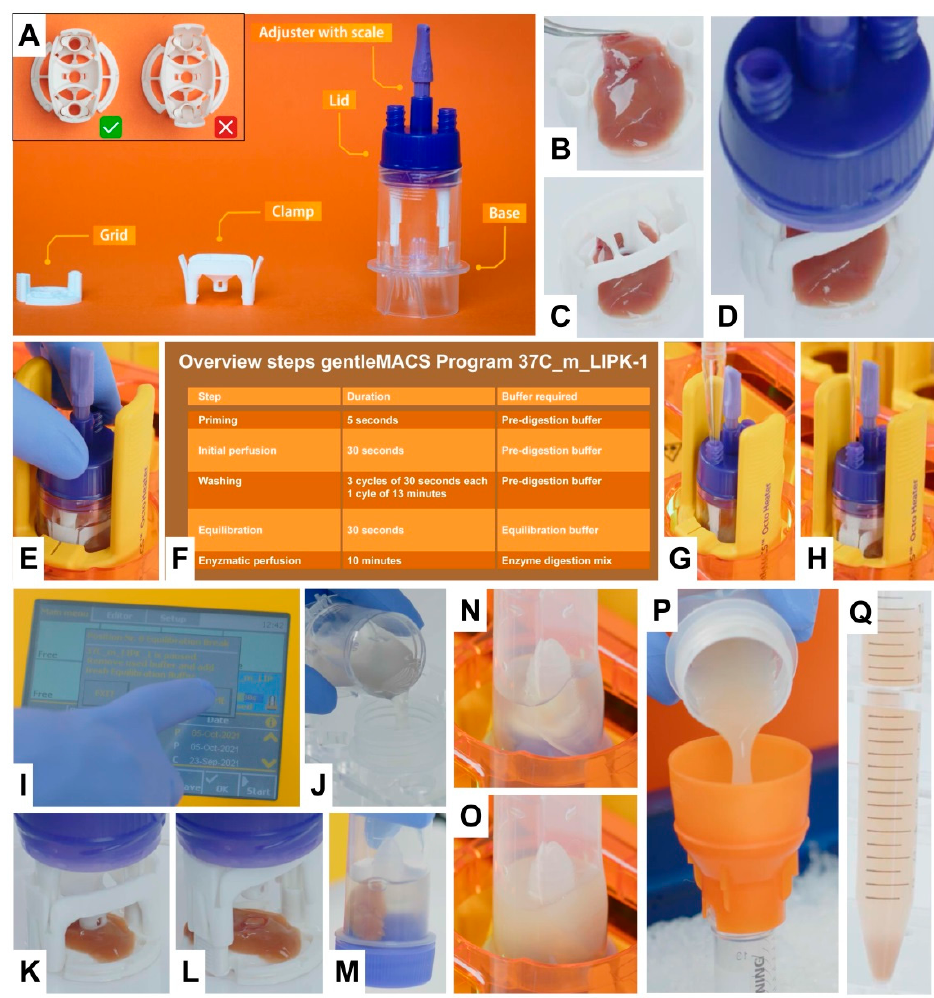
Figure 2. Selected working steps for the isolation of primary mouse hepatocytes using the gen- tleMACS Perfusion Technology. ( A ) The gentleMACS Perfuser components. The inlet shows how the Clamp should be inserted into the Grid. ( B , C ) Prior to perfusion, the liver lobe is placed on the Grid and fixed with the Clamp. ( D ) The Lid connected via the Grid holder to the Grid-Clamp assembly. ( E ) Lid-Clamp-Grid structure screwed into the Base of the gentleMACS Perfuser. ( F ) Overview of program steps of the gentleMACS Program 37C_m_LIPK_1. ( G , H ) Addition and removal of buffers after each cycle can be done via one of the Luer locks on top of the Lid. ( I ) Display of the gentleMACS Octo Dissociator with Heaters. ( J ) Filling of the used enzyme digestion mix from the Base into a gentleMACS C Tube. ( K , L ) Lifting of the Clamp after completion of the per- fusion to enable transfer of the perfused lobe into the gentleMACS C Tube. ( M ) Tissue after transfer from the Grid into the C Tube containing the used enzyme digestion mix. ( N ) gentleMACS C Tube containing perfused liver placed on the gentleMACS Dissociator. ( O ) Cell suspension in C Tube after running Program LIPK_HR_1. The release of hepatocytes from the tissue results in cloudiness of the solution. ( P ) Filtering of cell suspension through the MACS SmartStrainer. ( Q ) Hepatocyte pellet after low-spin centrifugation. The detailed protocol is given in Appendix A.